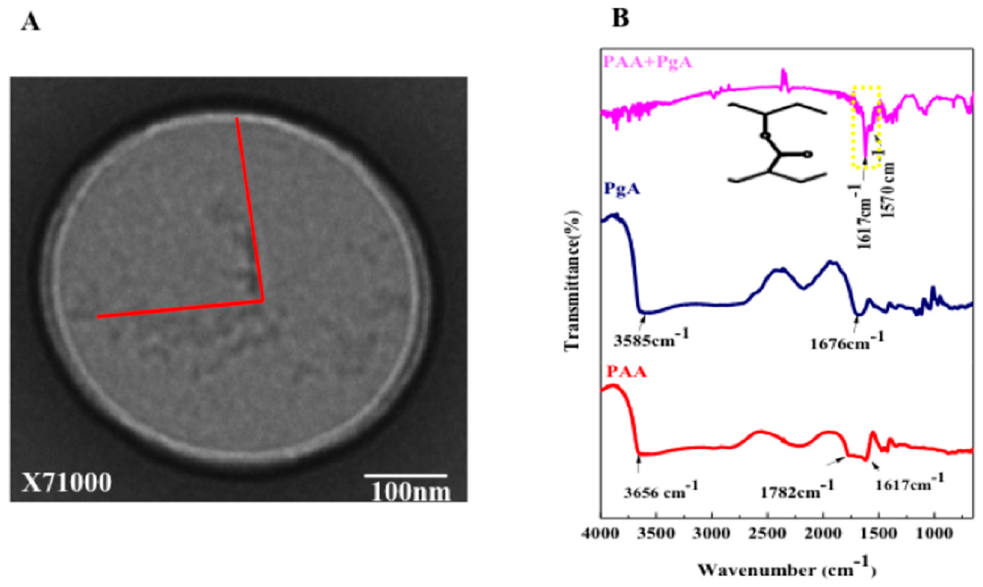
Figure 6. Characterization of Polygalacturonic acid (PgA) esterified Polyacrylic acid (PAA) nano-micelles. ( A , radial arrows indicate round-shaped micelle) TEM image of a nano-micelle and ( B ) FTIR spectra of PGA/PAA nano-micelles conjugation.